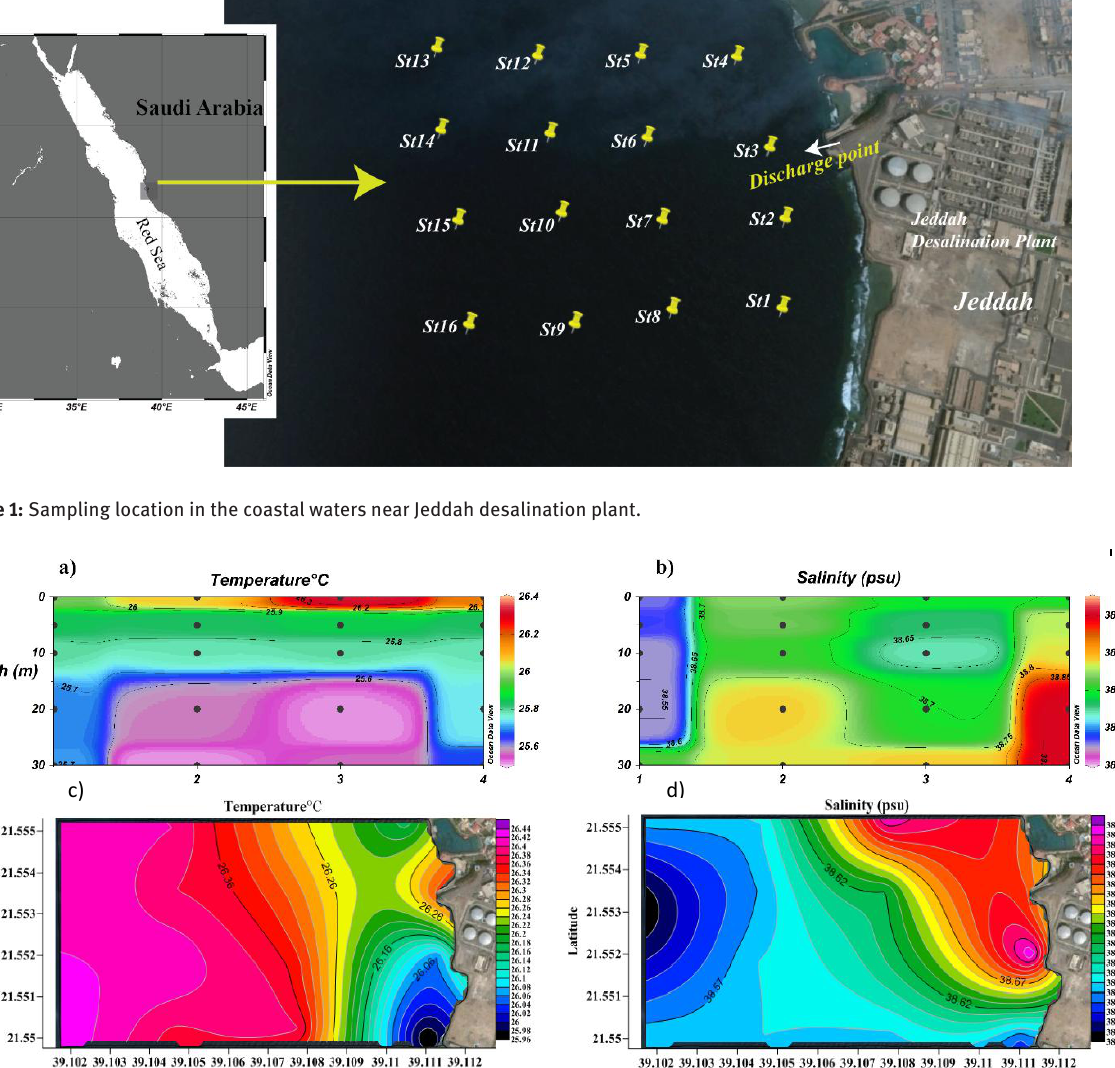
Figure 2: Cross-section profile of a) temperature and b) salinity; surface distribution pattern of c) temperature and d) salinity.